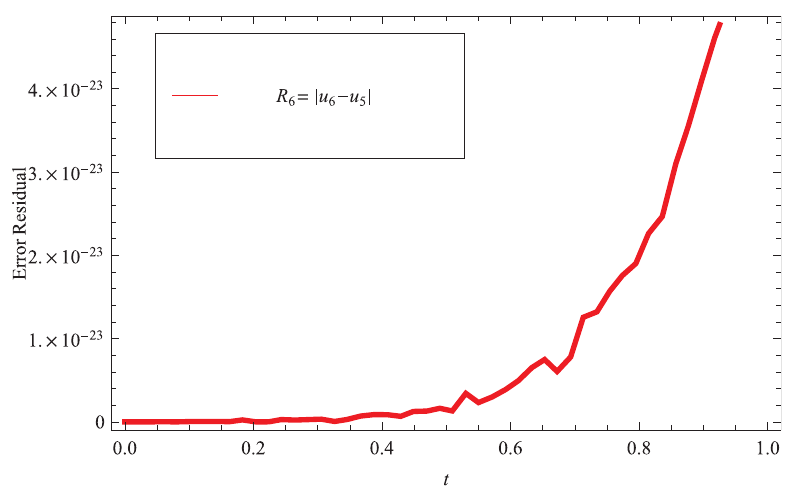
Figure 8. Plot of residual error R 6 = | u 6 − u 5 | by